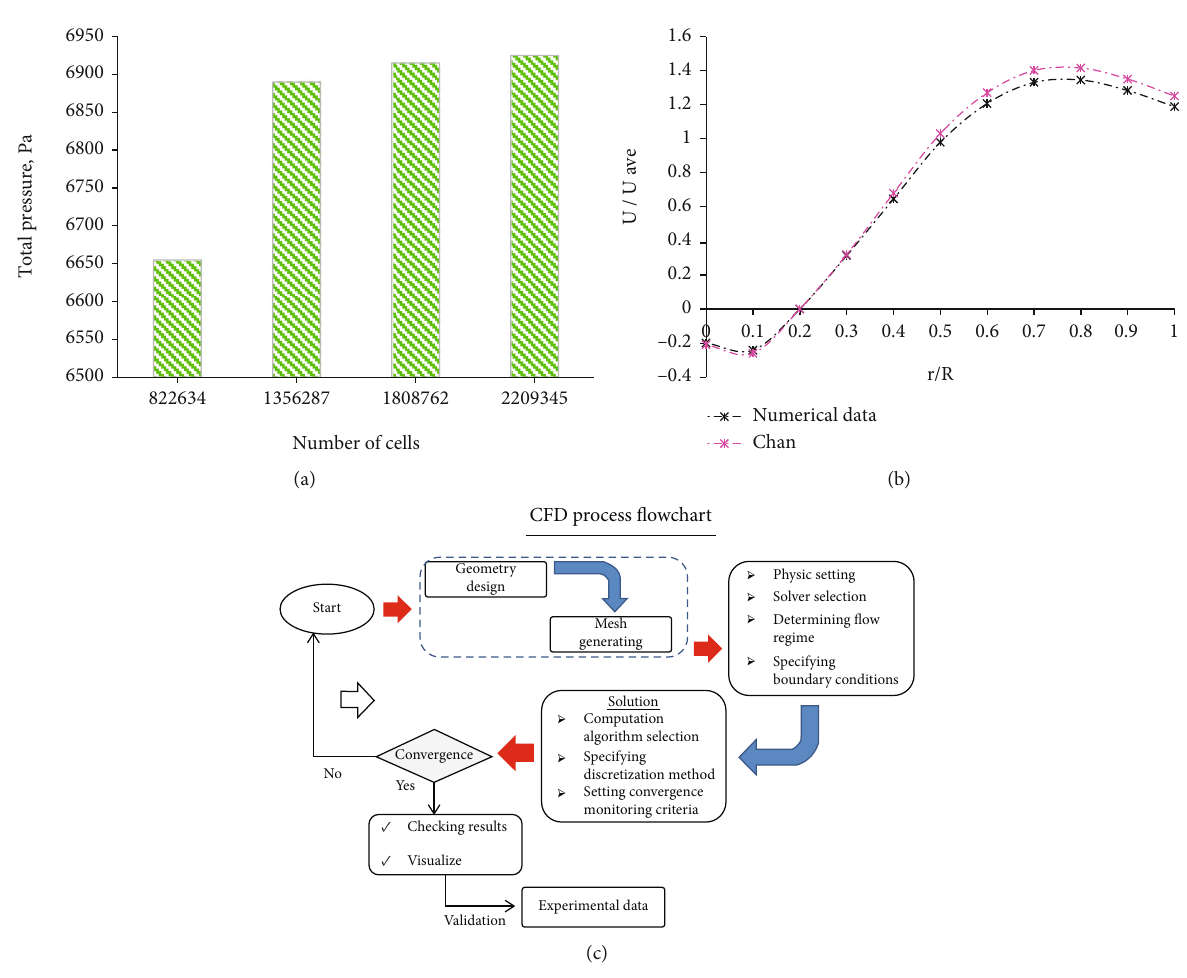
Figure 2: (a) Grid independency results. (b) Validation results. (c) CFD process fl owchart.